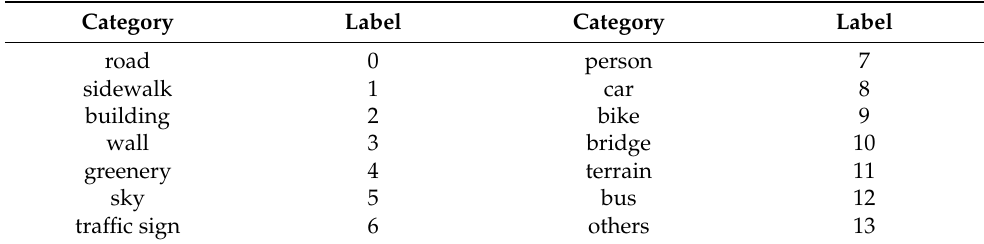
Table 1. The description of segmentation categories.